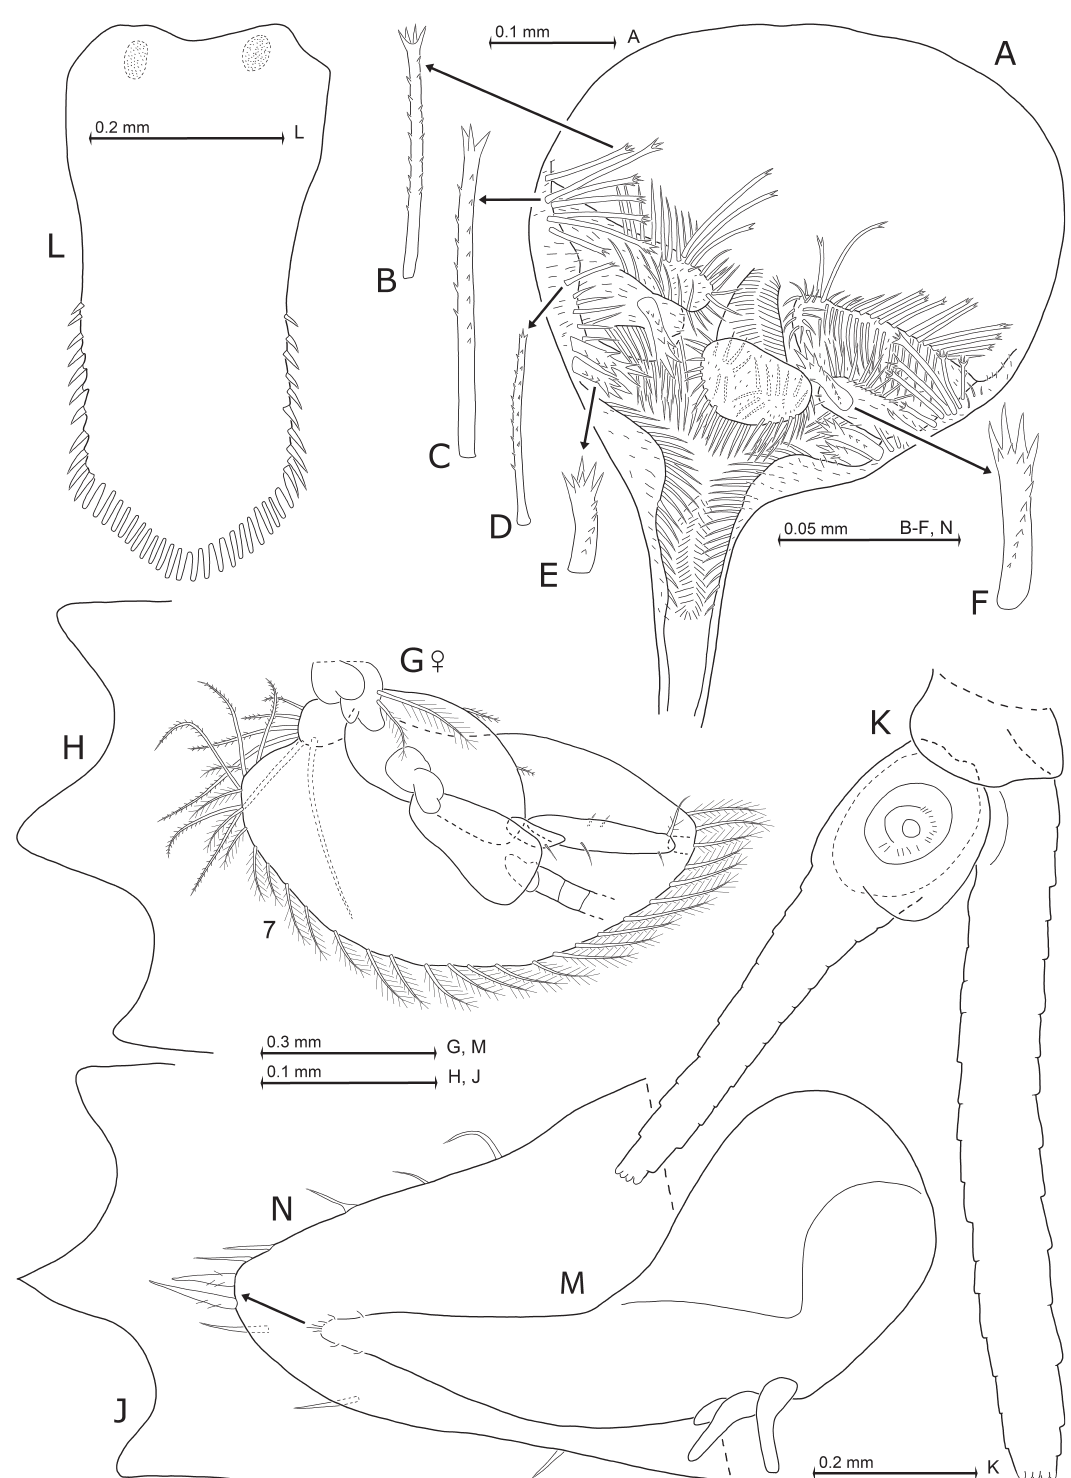
Fig. 8. Mysidium triangulare Wittmann sp. nov., from Curaçao, paratypes. A–F . ♀, 5.9 mm body length. G, J . ♀, 5.1 mm. H, K–L . ♂, 5.5 mm. A . Foregut; dorsal wall omitted. B–F . Details of panel (A) showing modified spines. G . Basal half of thoracopod 7 with right oostegite, lateral view. H , J . Variants of scutellum paracaudale, lateral view. K . Uropods, ventral view; setae omitted. L . Telson. M . Nauplioid larva at substage N2, lateral view. N . Detail showing tip of abdomen in another nauplioid specimen.